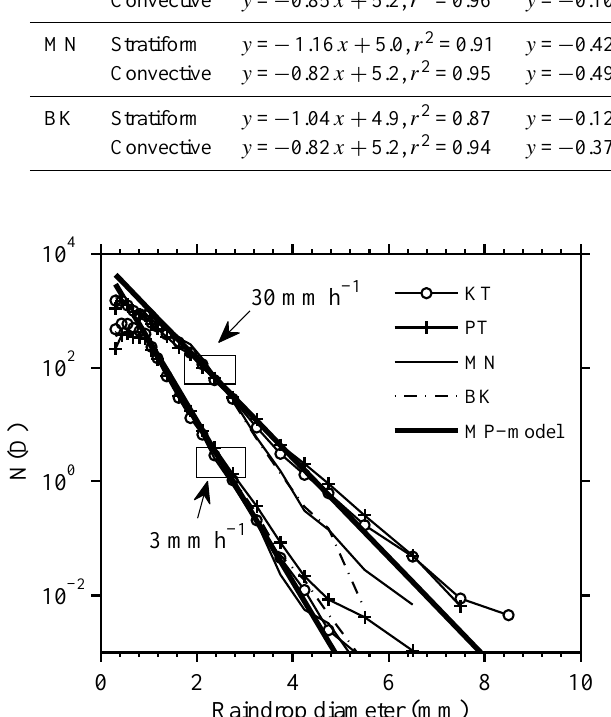
Fig. 3. Averaged drop size distributions around 3 and 30mmh − 1 for the four locations along with the Marshall–Palmer model ( N(D) =8000 e − 3D , where 3 =4.1 R − 0 . 21 ).